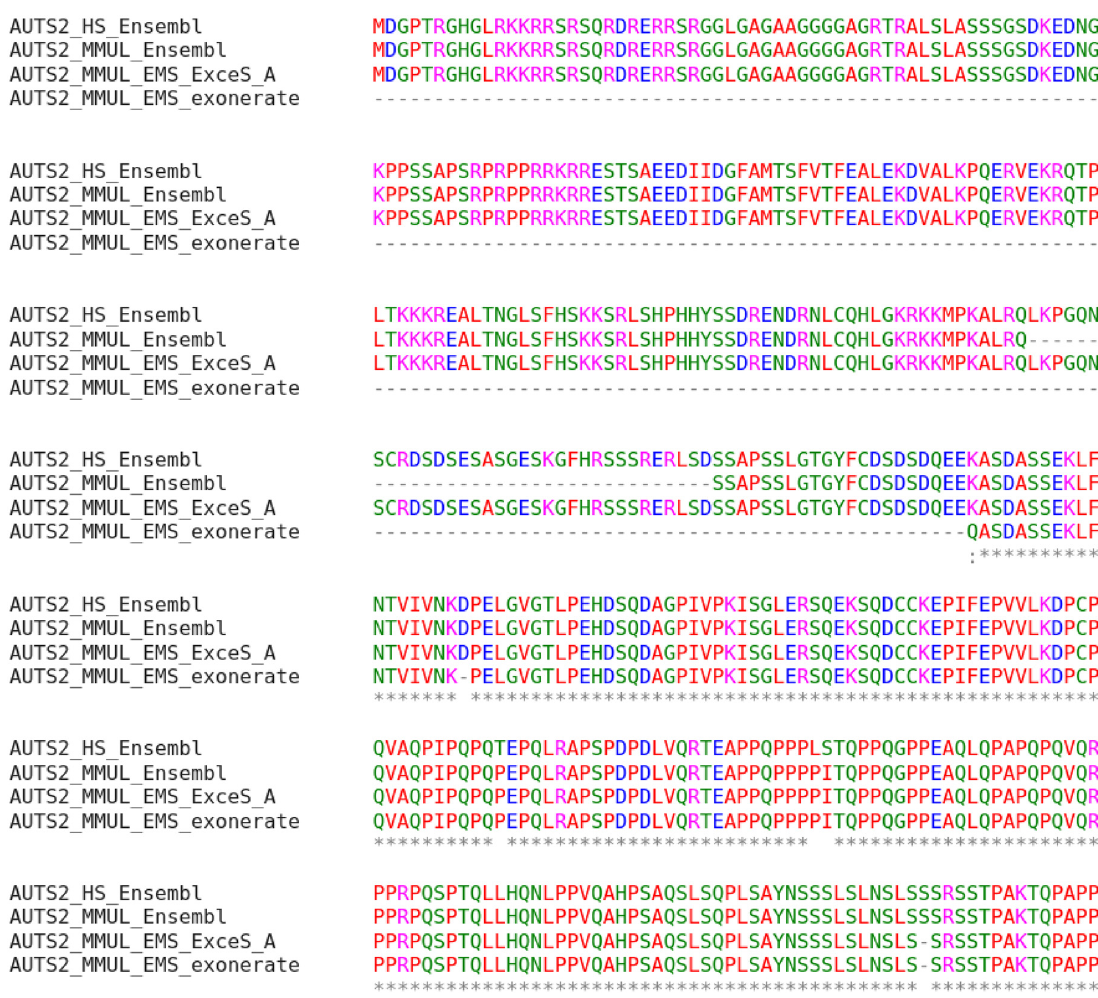
Figure 4: Reconstruction of AUTS2 in Macaca mulatta (MMUL) using the human (HS) protein. The ExonMatchSolver pipeline (EMS) is used with ExceS-A and the combination of Exonerate and ProSplign as spliced aligners. The Ensembl annotation for the macaque AUTS2 is shown for comparison. ExceS-A identifies perfectly preserved orthologous sequences, while Exonerate fails to identify the 5 ′ part of the molecule due to the long intron. The Ensembl annotation also misses one